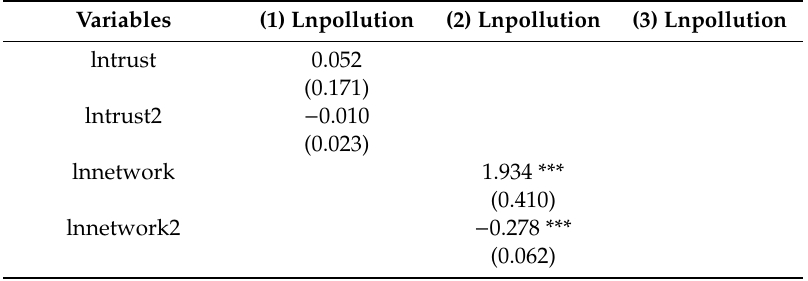
Table 3. Regression results of di ff erent types of social capital on